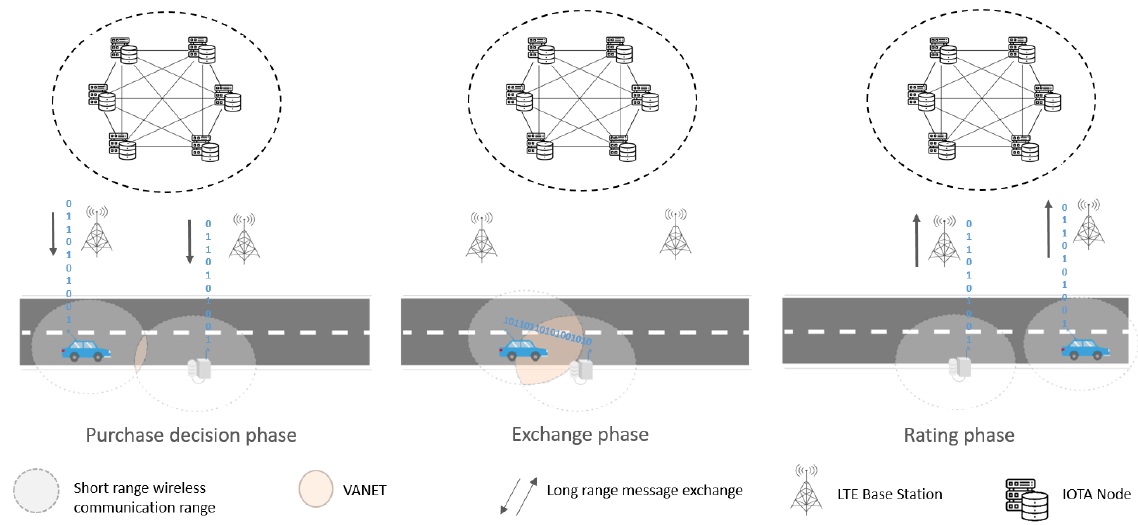
Figure 1. Schematic overview of the data trading system. For better readability, we have omitted the communication with the distributed ledger for the creation of the multi-signature address in the exchange